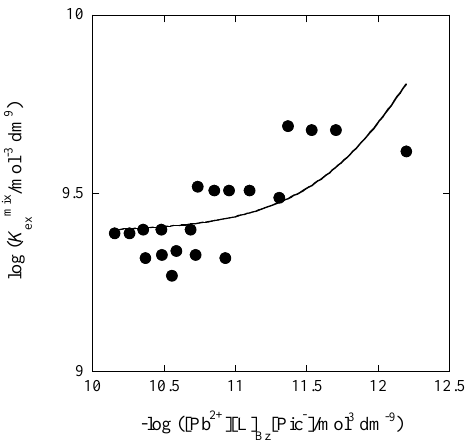
Figure 2. Plot of log K exmix versus − log ([Pb 2+ ][L] Bz [Pic − ]) with L = B18C6 at [Cd] t /[Pb] t = 88.5. The line is based on Equation (3).